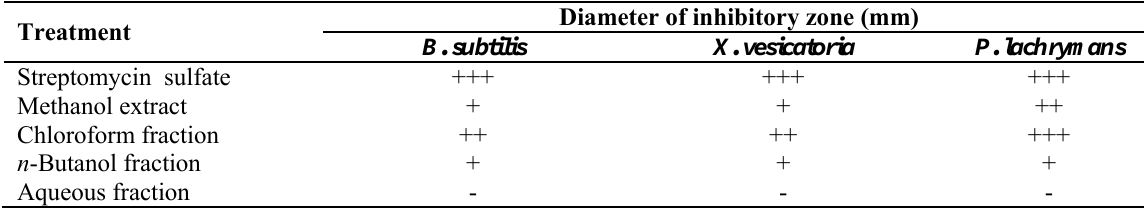
Table 2. Bacteria growth inhibition activity of the crude methanol extract and fractions of cucumber stems.